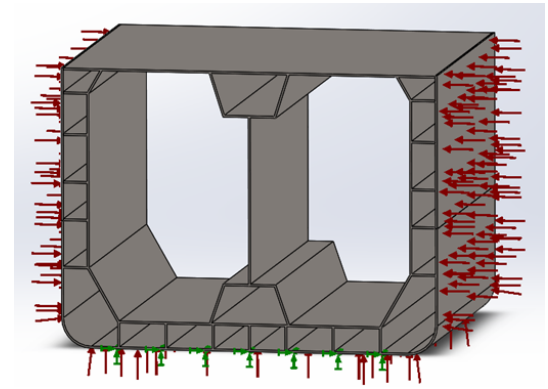
Figure 6: Applied load and boundary